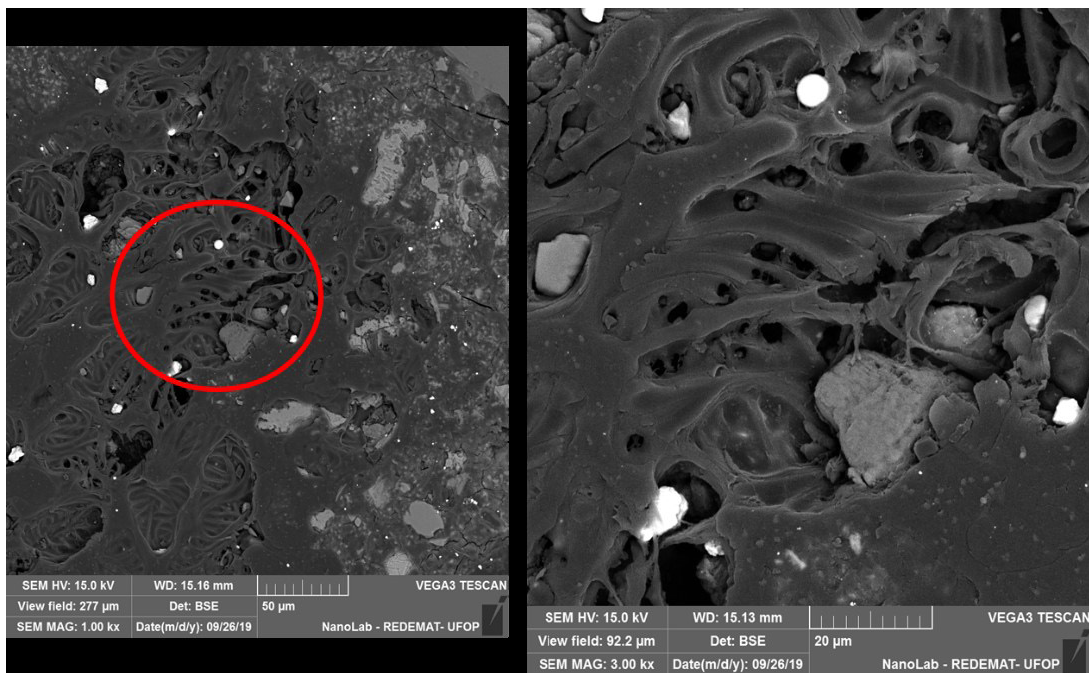
Figure 6. Micrograph of sample AF100-02 tested at 7 days with magnification of 1000x and 3000x.